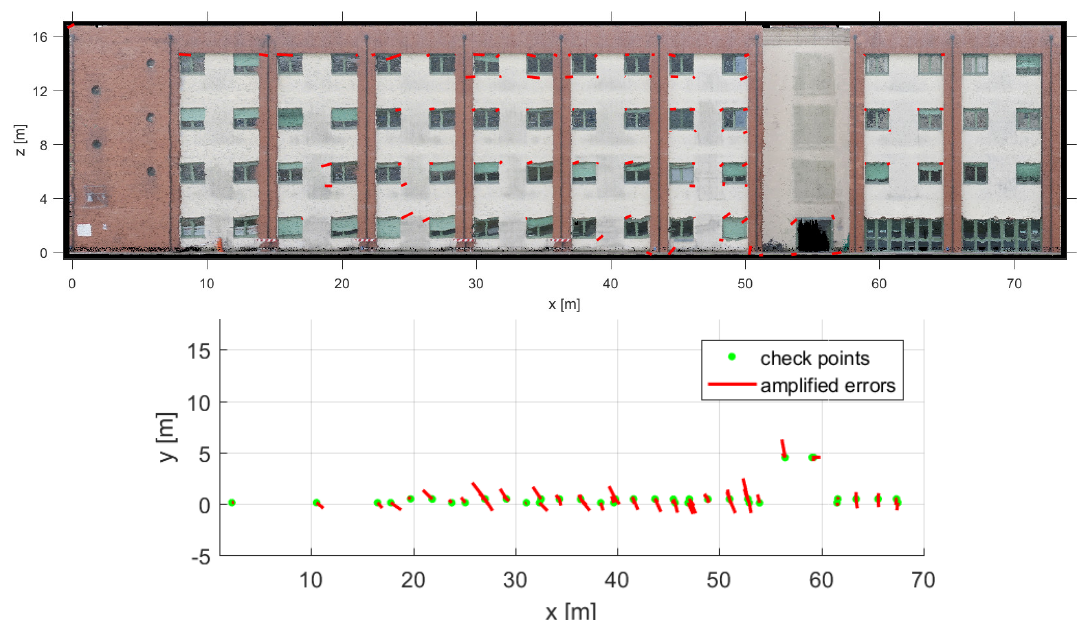
Figure 7. Errors, amplified by a factor of five with respect to the reconstruction scale, on check points for the reconstruction in local coordinates. Frontal view of the building façade ( top ) and top view ( bottom ).